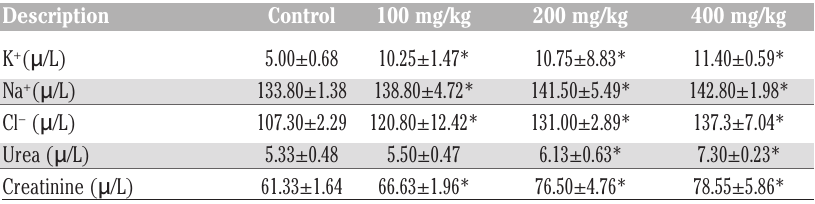
Table 3. Toxicological effect of Solignum ® on serum electrolytes in